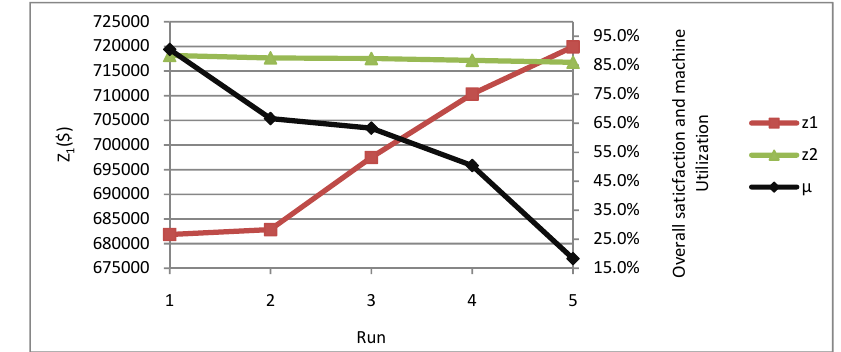
Fig. 8. Sensitivity analyses on escalation variation